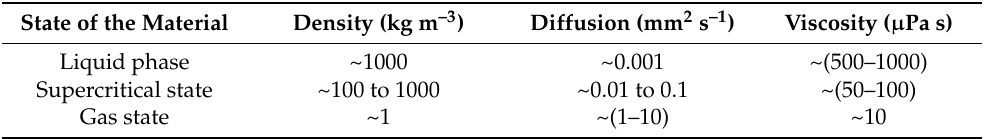
Table 3. Typical physical properties of the gas, liquid, and supercritical fluids. Adapted from Hong G.T. [80], reprint permission had been obtained from the American Chemical Society (Copyright